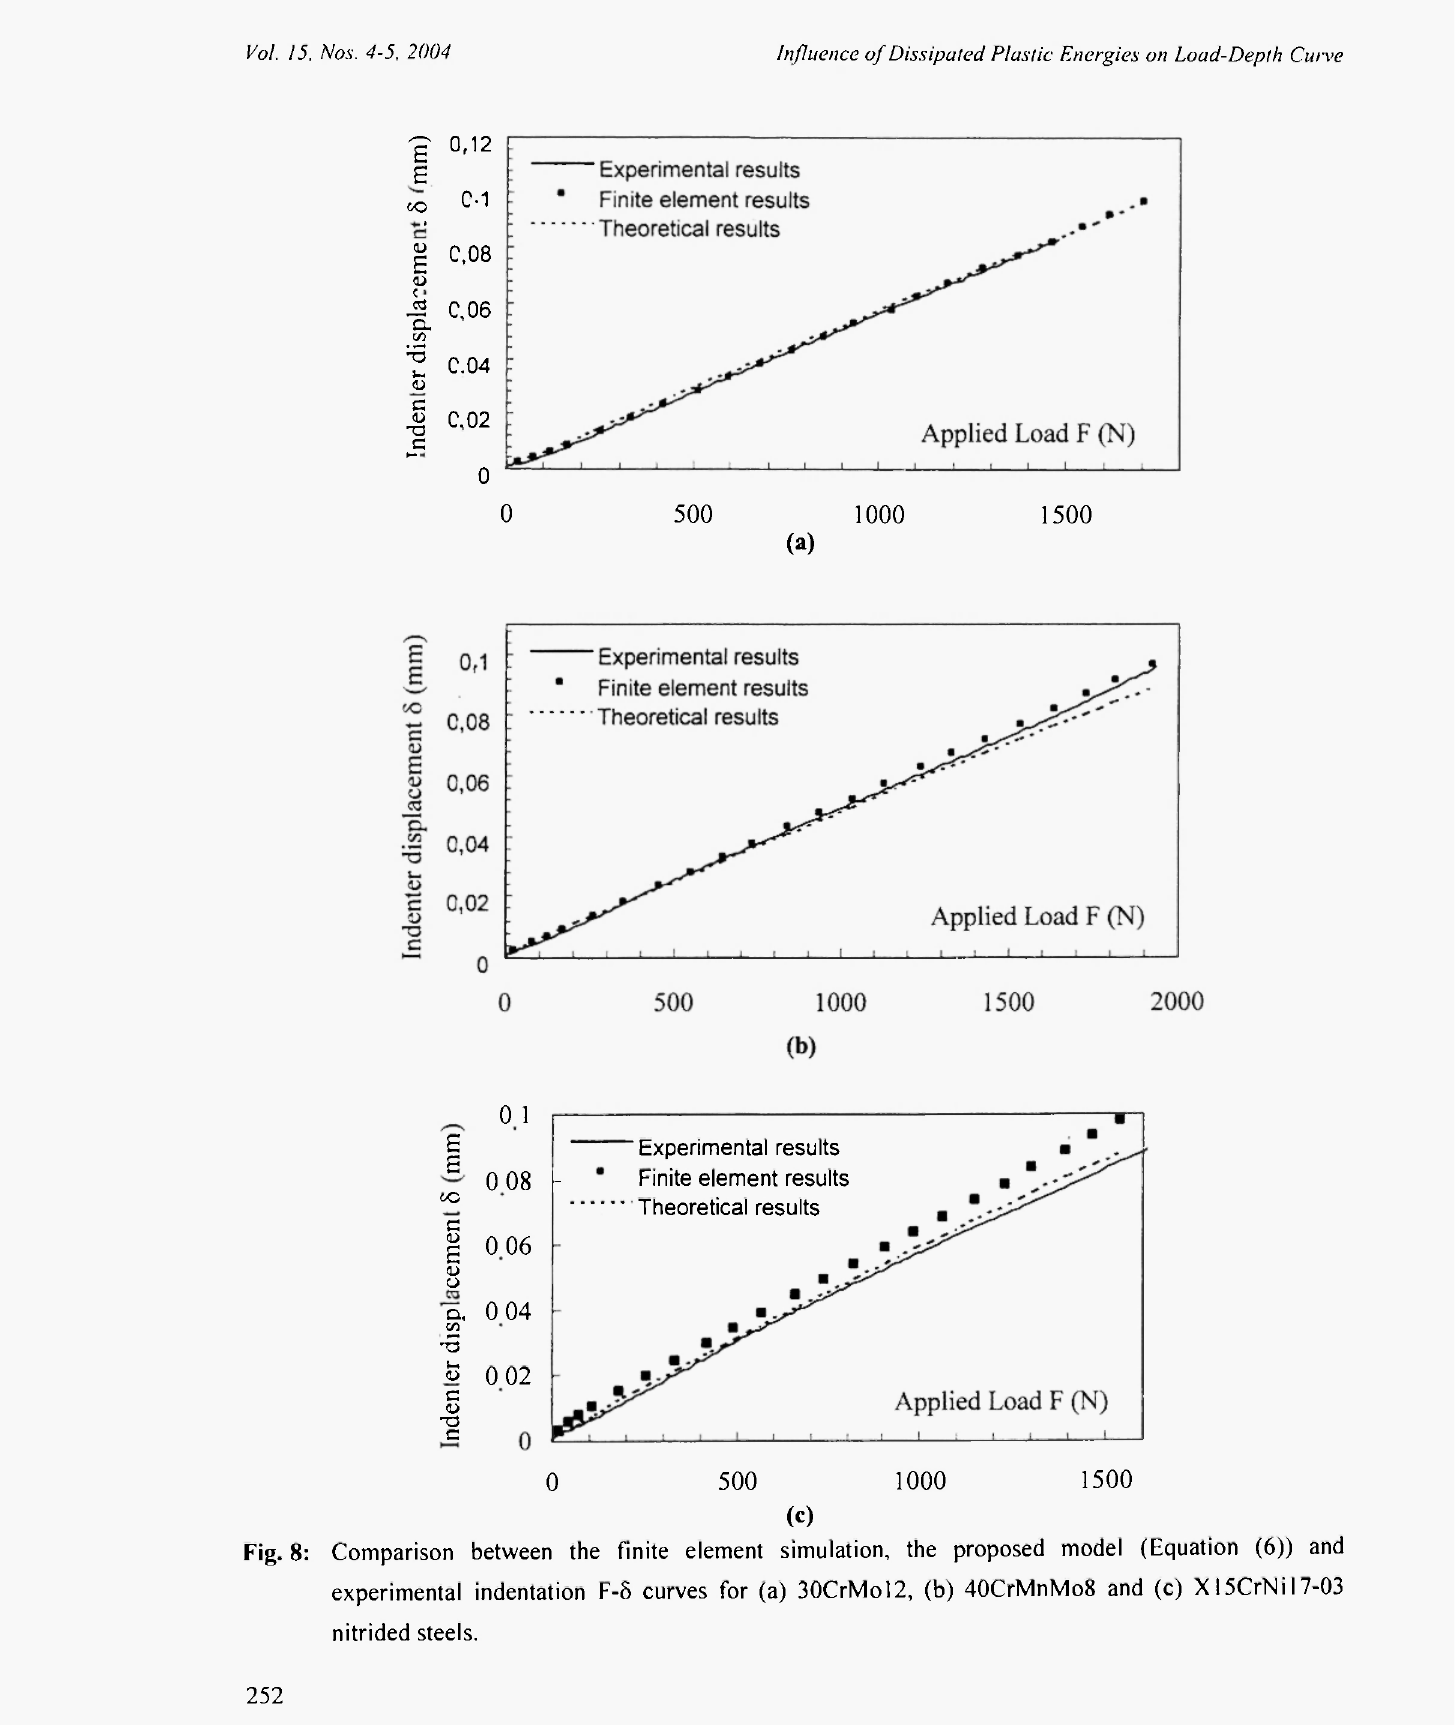
Fig. 8: Comparison between the finite element simulation, the proposed model (Equation (6)) and experimental indentation F-δ curves for (a) 30CrMol2, (b) 40CrMnMo8 and (c) X15CrNil7-03 nitrided